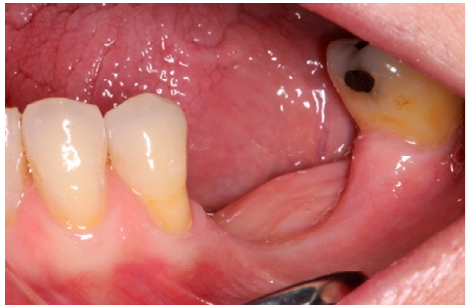
Figure 1. Vertical bone defect in the intraoral examination of the third quadrant.